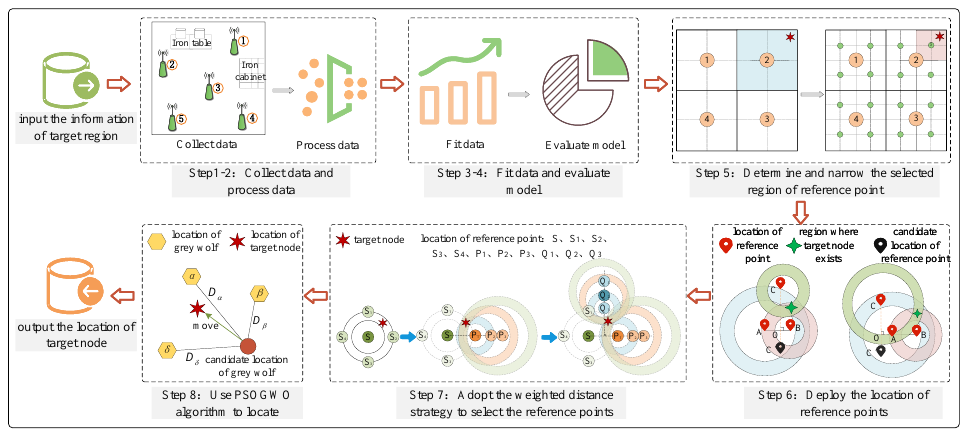
Step 6 ： Deploy the location of reference points